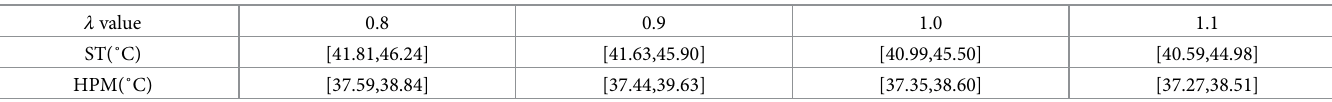
Table 7. The optimal solutions under different